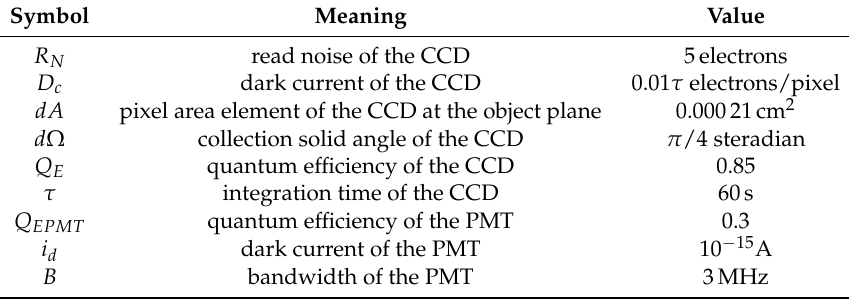
Table A2. Parameters used in signal-to-noise ratio (SNR)